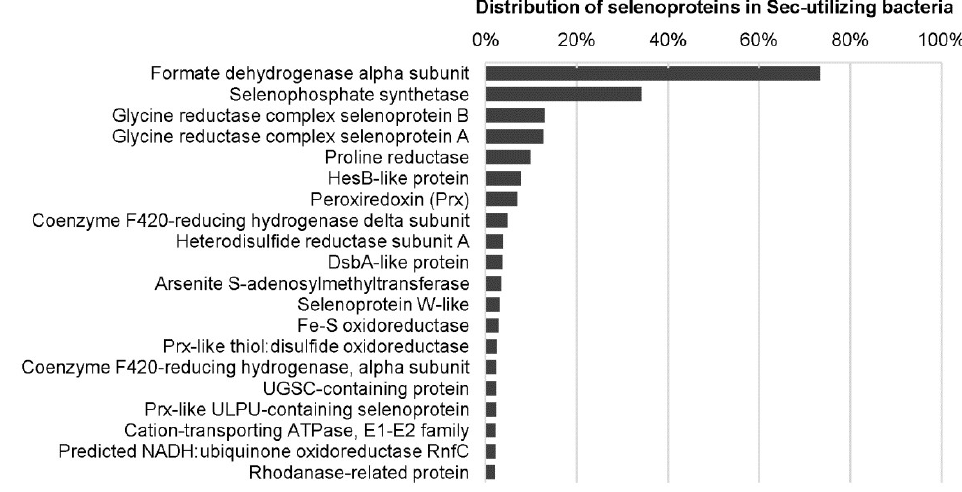
Figure 3. Distribution of the top 20 selenoproteins in Sec-utilizing bacteria. Data used to generate this figure can be found in [114].